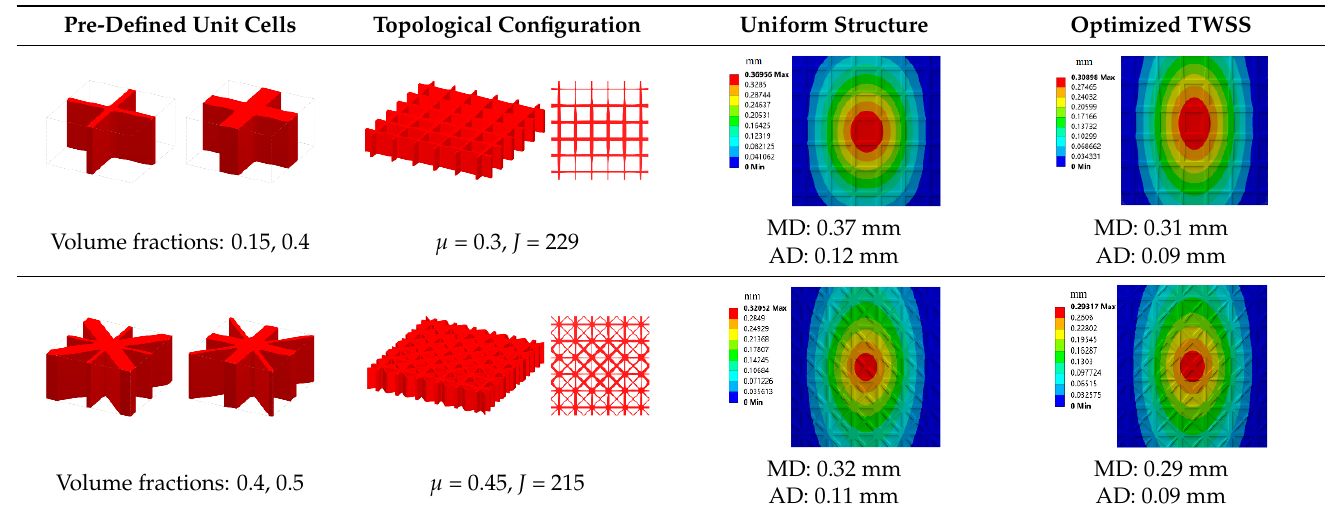
Figure 12. Pre-defined unit cells and design domain of FGCS. ( a ) I-WP TPMS with different volume fractions. ( b ) Loading and boundary conditions for 3D Michell beam. The optimization based on I-WP TPMS unit cells converges to J = 1910.96 after 60 iteration steps. The evolving history is plotted in Figure 13. Figure 14 shows the final